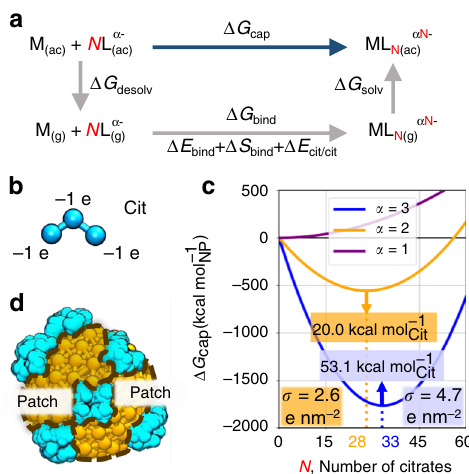
Fig. 1 Theoretical model for calculating the number of charged ligands bound to a spherical NP. a Thermodynamic cycle on which the proposed theoretical model is based. Δ G cap is obtained in this thermodynamic cycle as Δ G desolv + Δ G bind + Δ G solv , where Δ G desolv is the desolvation energy of the NP core (M) and N ligand molecules (L); Δ G bind is the energy for binding those ligands onto the NP in vacuum; Δ G solv is the solvation free energy of the resulting capped complex, in which the ligands are modeled as an enveloping uniformly charged sphere. b Explicit coarse-grained model for citrate molecule (Cit), which was parametrized against atomistic MD simulations (see Supplementary Discussion 1f). c Binding energy as a function of N . The model is solved for the three deprotonation states of citrate, i.e., α = 1, 2, 3. The energy minima predict the most likely values for N that, in turn, set the surface charge density ( σ ) of the NP. d Conceptual illustration of a citrate-capped (cyan) nanoparticle showing the presence of catalytically available hydrophobic patches (brown) as suggested by the estimated surface area ligands may change when these bind to the NP surface 20 . The second input, the binding energy between citrate and gold surfaces, was taken from DFT-based calculations reported elsewhere 19 .